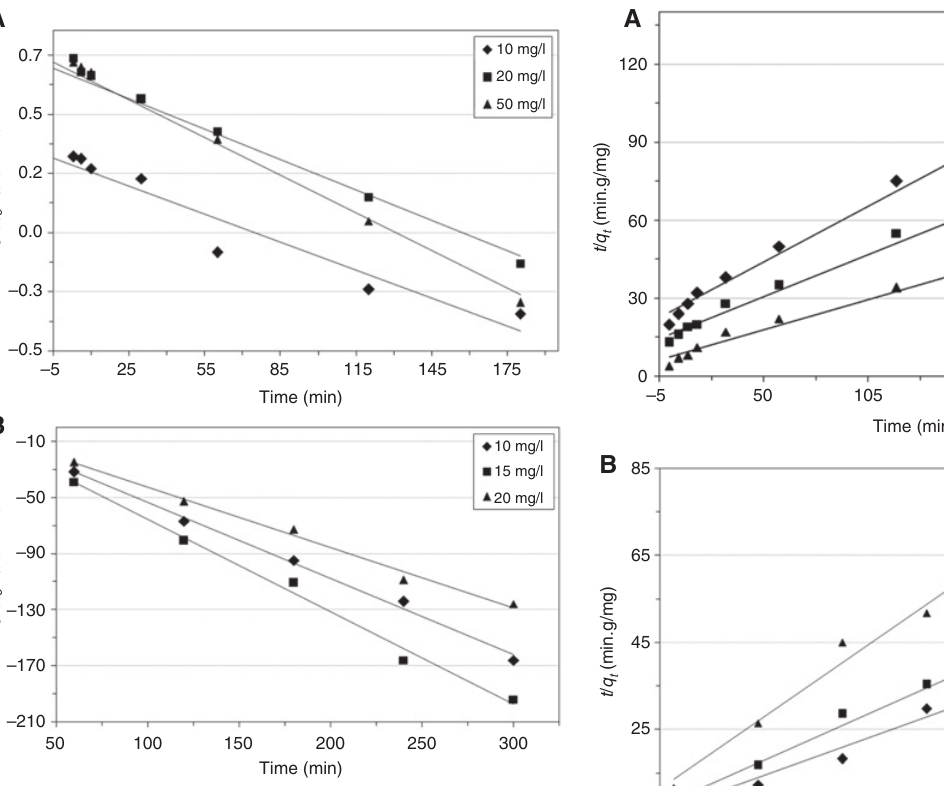
Figure 6: Pseudo-first-order plots for Mn-doped laterite: (A) phos- phate, (B) fluoride.